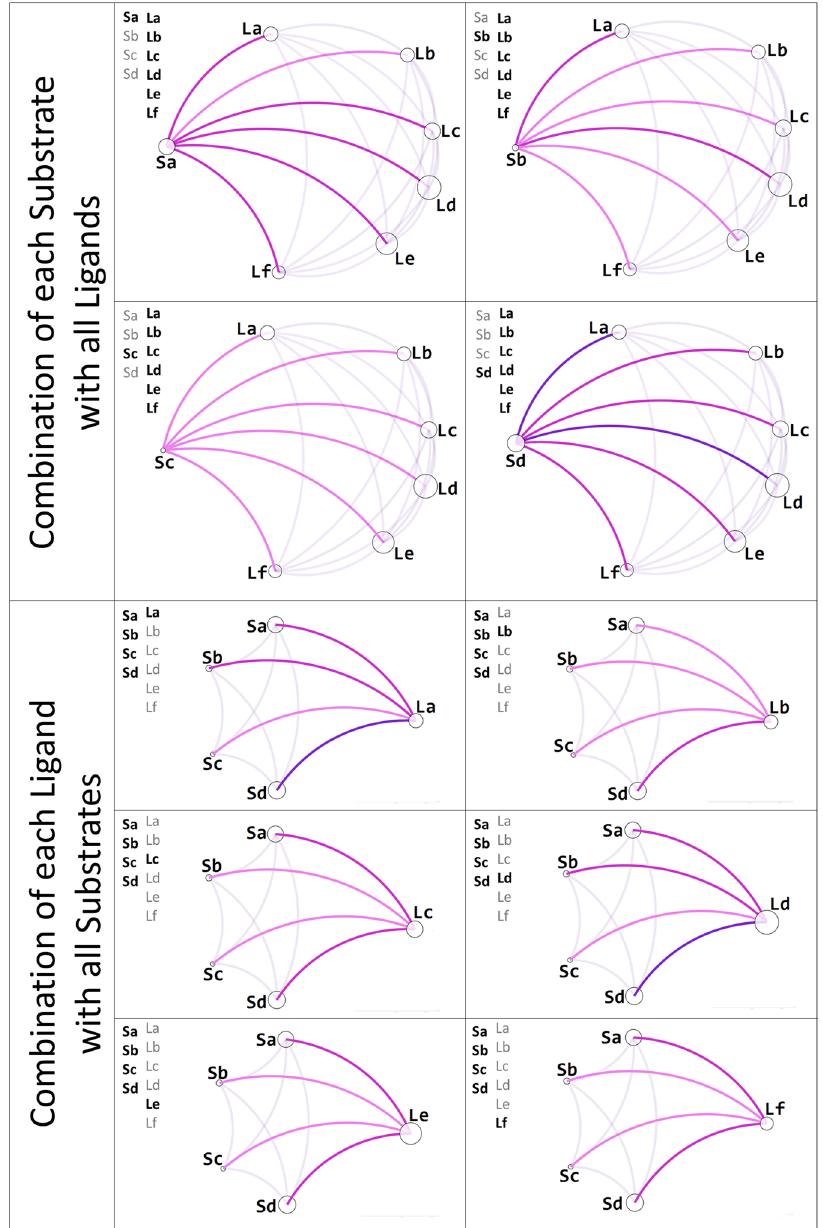
Figure 9. Mutual information among the substrate and ligand descriptors computed by CODES-TSAR (CT EE compound datasets for QSAR modeling of three different issues: blood-brain-barrier, human intestinal absorp- tion, and enantiomeric excess. Each dataset used during the machine learning experiments was characterized in detail by drug-like proper- ties calculation and similarity assessment of their molecular descriptors. In all cases, QSAR model performances were contrasted for several experimental conditions, varying sampling parameters and techniques used for infer- ring the classification and regression models. The molecular descriptor subsets obtained by DRAGON-DELPHOS and CODES-TSAR strategies were also analyzed in terms of mutual information and correlation, in order to evaluate the pairwise associations among the relevant descriptors and their relationships with the properties under study. From the results, we observed that none of the methods outperform the other one in all scenarios since the prediction accuracy depends on database features and experimental conditions. Nevertheless, regarding the training methods used for QSAR model inference, the techniques based on ensembles, Random Forest and Random Committee, outperform with statistical significance the most traditional algorithms in the two kind of QSAR models (regression and classification). For this reason, we recommend to practitioners to apply ensemble based methods for the model training step.